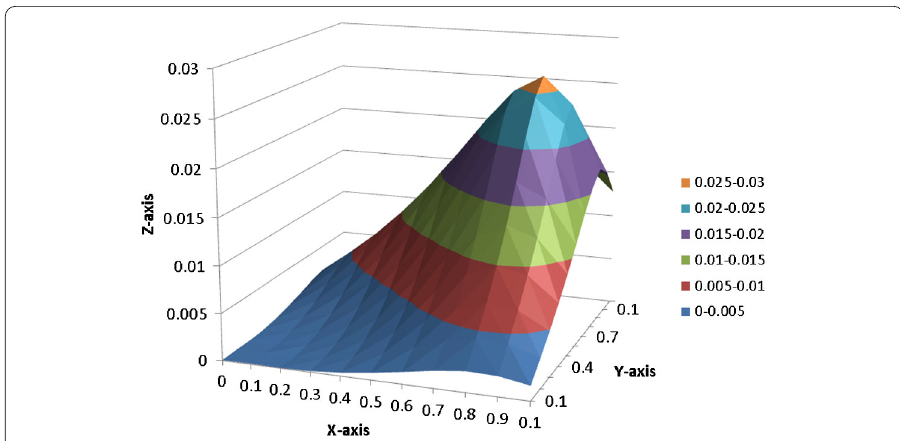
Figure 14 Numerical solution by the FSkG(C-N) method when α = 0.70 of Example 2